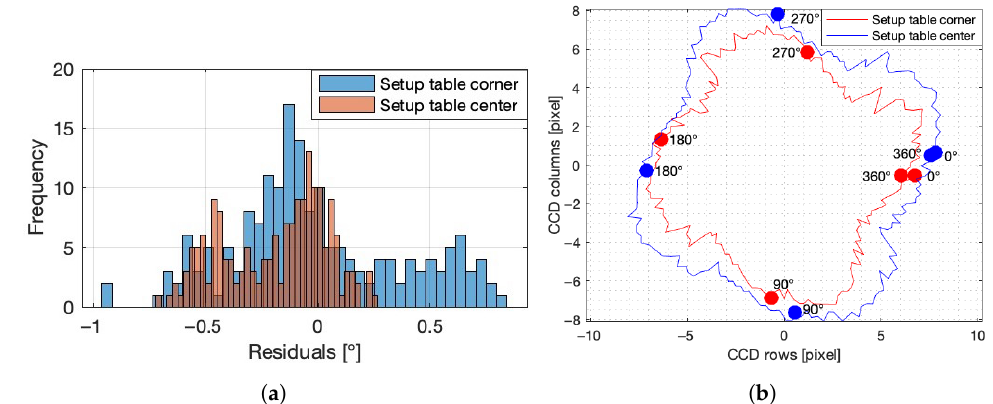
Figure 12. ( a ) Histograms of residuals and ( b ) object center positions during rotations in the two setups.